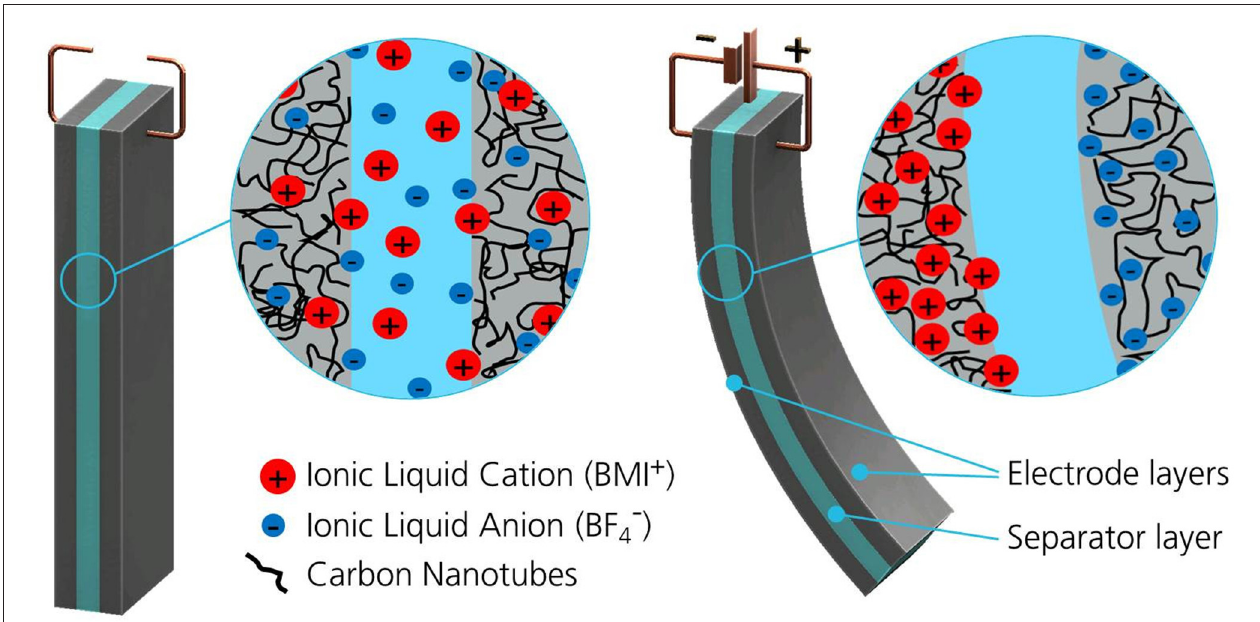
FIGURE 2 | Illustration of CNT “Bucky gel” actuator in the non-actuated and in the actuated state. The curvature is mainly caused by charge induced transport of differently sized ions into the electrode